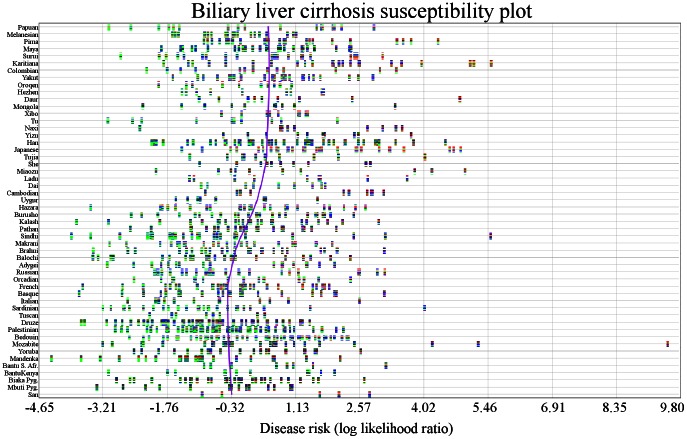
Variability in genetic risk in biliary liver cirrhosis.Individuals are represented by vertical multicolored rectangles. Bar colors indicate the following: red: homozygosity for a risk allele; blue: heterozygosity; green: homozygosity for a protective allele; white: missing genotype. The x-axis shows risk and the y-axis shows each population. The purple line is a locally weighted linear regression curve displaying the general direction of disease susceptibility as populations migrated from West to East. No trend is obvious, but risk appears to be higher in Cambodian, Yizu, Japanese, and San populations.